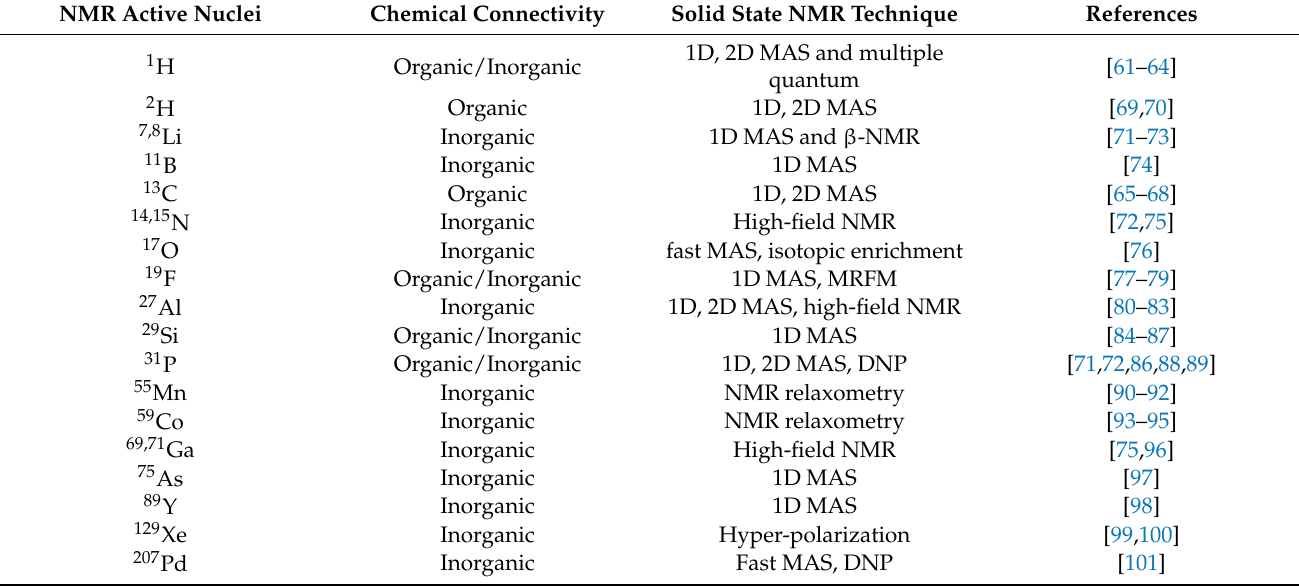
techniques for different thin-film types are summarized below in Table 1. Table 1. A summary of the most suitable solid-state NMR techniques for the chemically different thin-film types. MAS: magic angle spinning; DNP: dynamic nuclear polarization; MRFM: magnetic resonance force microscopy. NMR Active